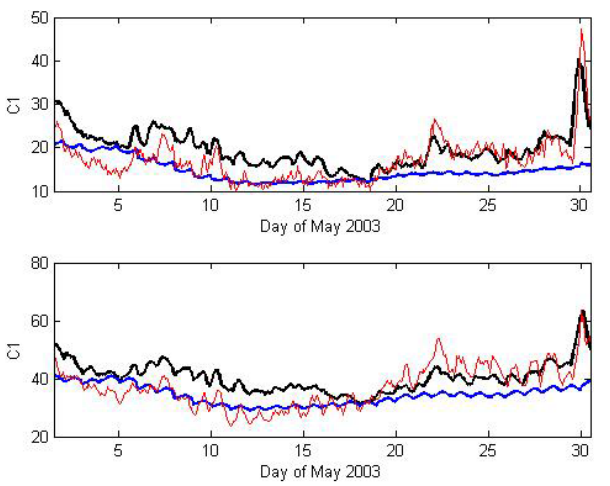
Fig. 5. Variations with UT of the c 1 projection coefficients for the densities estimated from the CHAMP/STAR observations (thin red lines), and for those computed using the actual (black lines) and quiet (blue lines) NRLMSISE-00 models (see text for the definition of the NRLMSISE-00 actual and quiet models). Upper panel: night time NS orbit segments; lower panel: day time SN orbit segments.